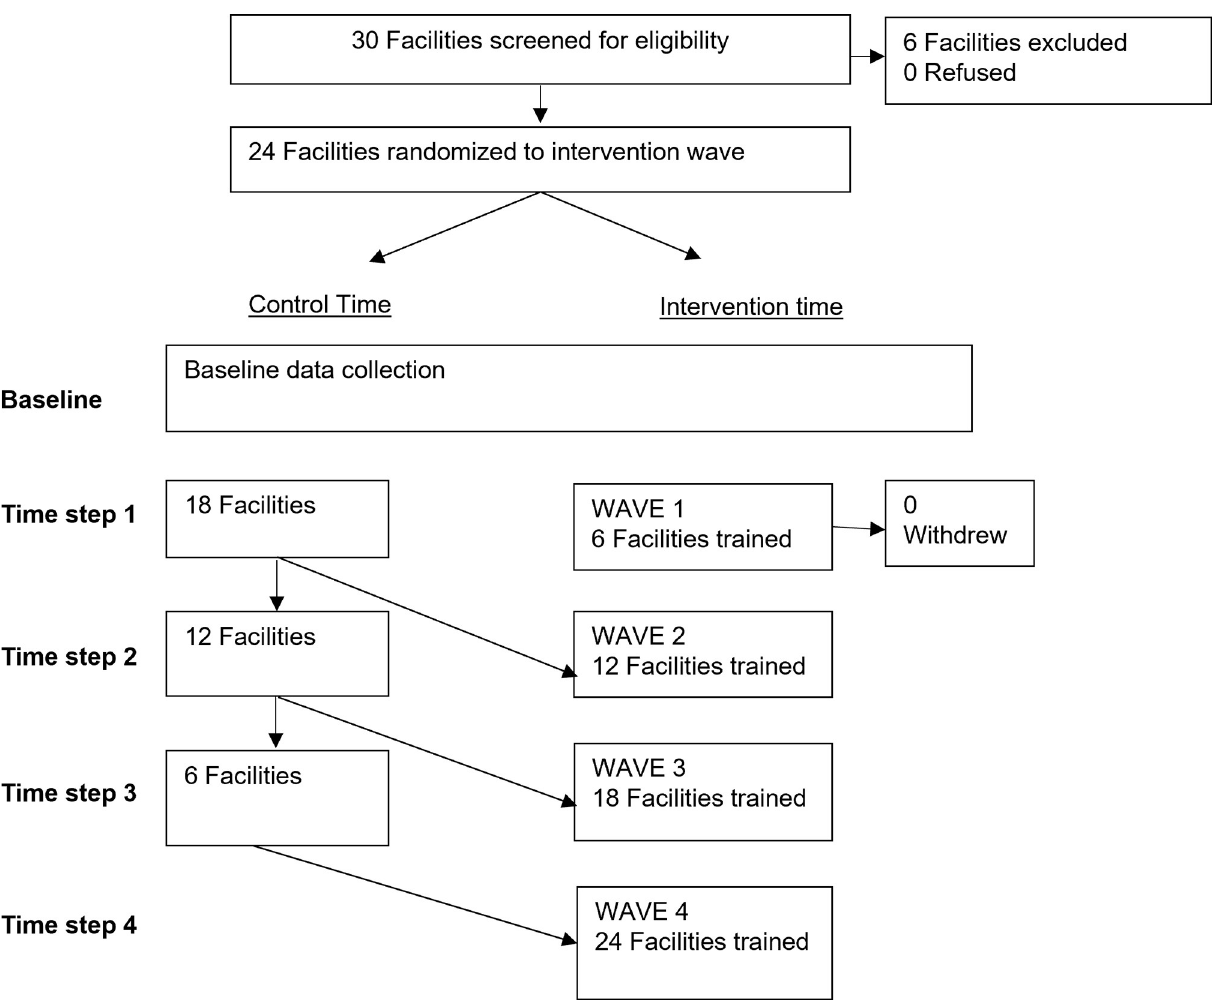
Fig 1. Adapted CONSORT diagram of SPEED intervention.